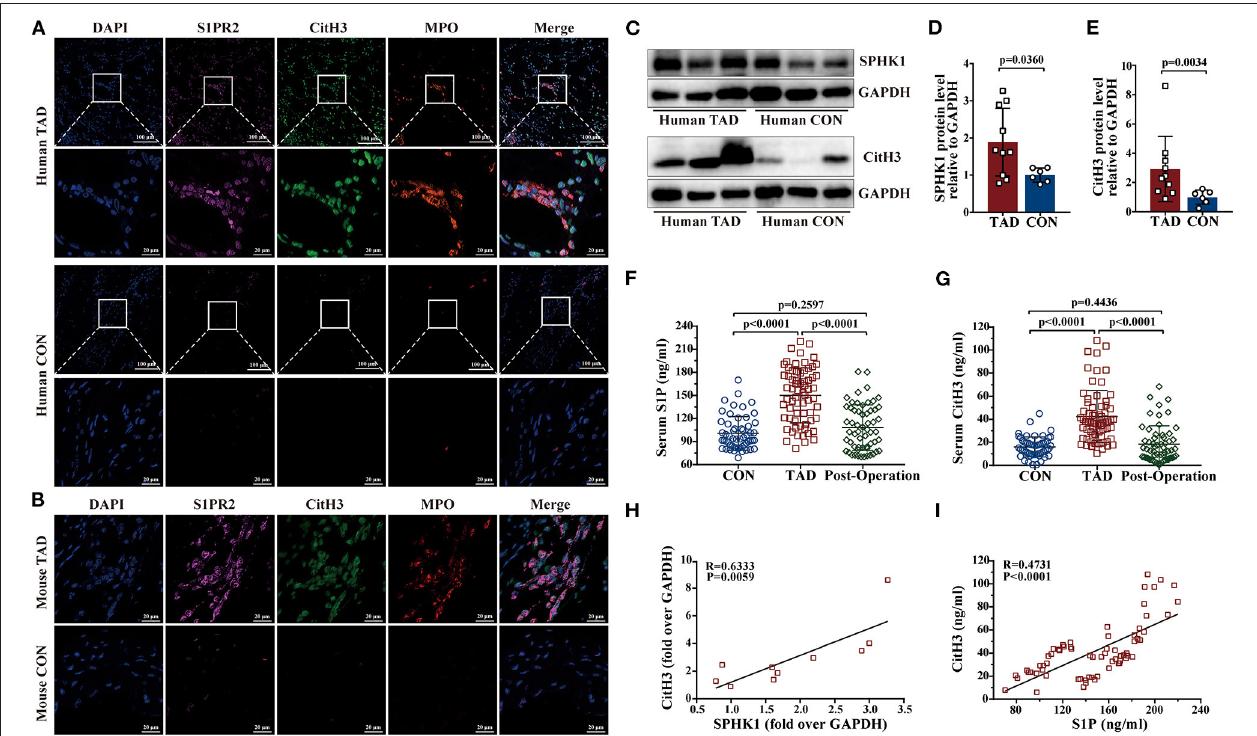
FIGURE 6 | Activated S1P/S1PR2 signaling and neutrophil extracellular traps (NETs) had a positive correlation. (A,B) Immunofluorescent staining showing the colocalization of S1PR2 and NETs in human and mouse TAD lesions. (C–E) Representative immunoblot and the corresponding analysis of human SPHK1 and CitH3 in TAD lesions ( n = 10) and normal thoracic aorta ( n = 6). (F,G) Serum S1P and CitH3 levels in the matched control ( n = 55), patients with TAD before surgery ( n = 67) and TAD patients after surgery ( n = 58). (H) SPHK1 protein level positively correlated with CitH3 protein level in patients with TAD. (I) Serum S1P level positively correlated with serum CitH3 level in patients with TAD. Scale: 100 µ m or 20 µ m. Data are expressed as means ± SD. CitH3, a specific marker of NETs; Myeloperoxidase (MPO), a marker for neutrophil abundance.